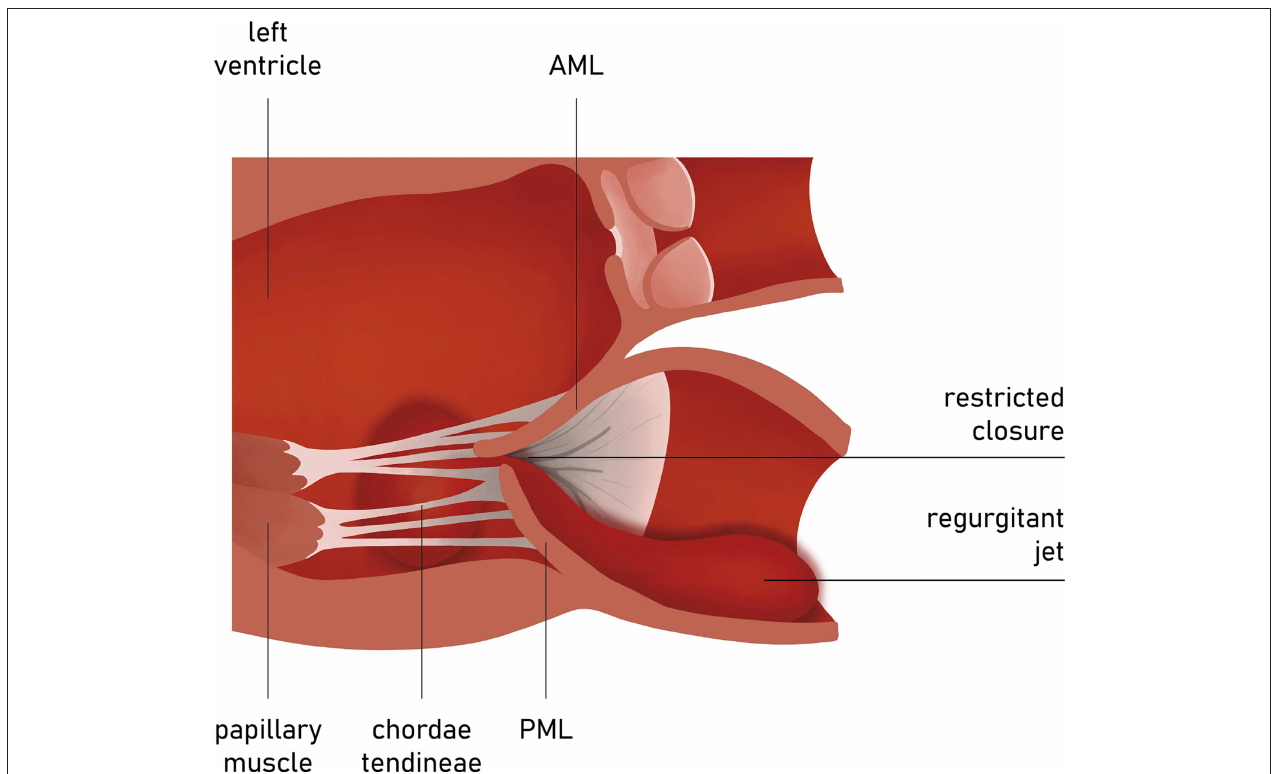
FIGURE 8 | Carpentier type III mitral regurgitation. Restricted leaflet motion. Regurgitation jet directed